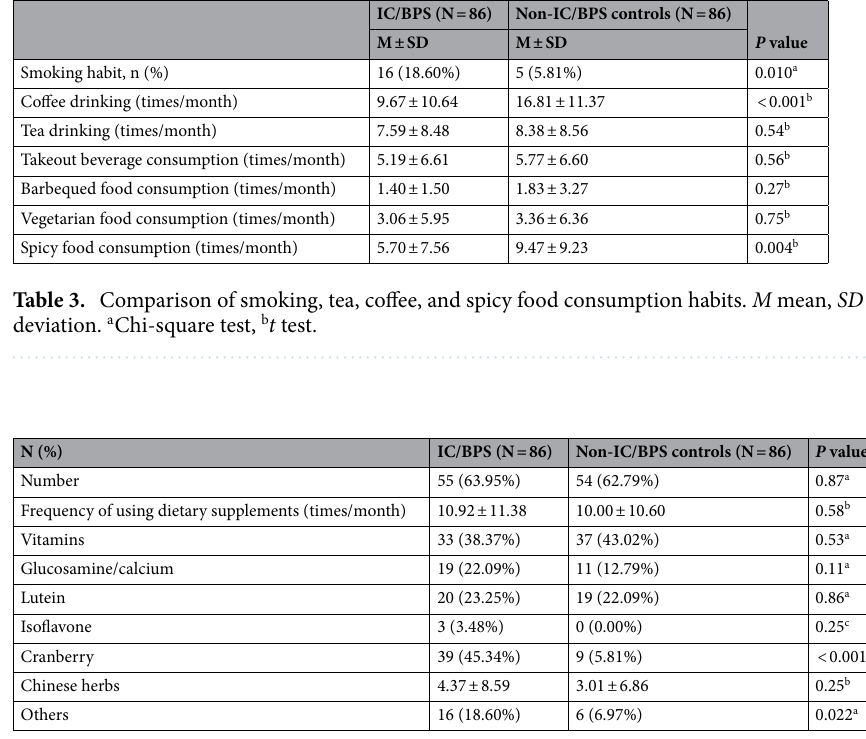
Table 4. Comparison of various types of diary supplements and Chinese herbs. a Chi-square test, b t test, c Fisher’s exact test. Vitamins include: Vitamin C, Vitamin B complex, Vitamin D, Vitamin E.